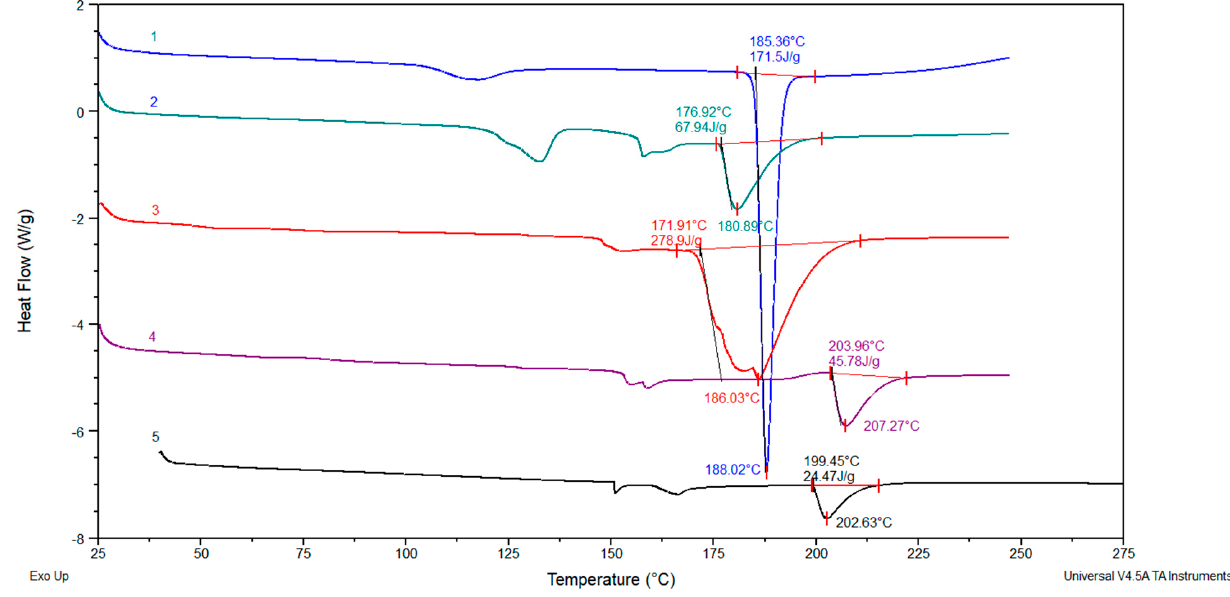
Figure 12. DSC curves: 1. curcumin, 2. p(NiPMAm/NiPAm) 10/90/2 hydrogel containing curcumin: 2-hydroxypropyl- β -cyclodextrin complex, 3. curcumin: 2-hydroxypropyl- β -cyclodextrin complex, 4. p(NiPMAm/NiPAm)10/90/2 hydrogel, 5. 2 ‐ hydroxypropyl ‐β‐ cyclodextrin.